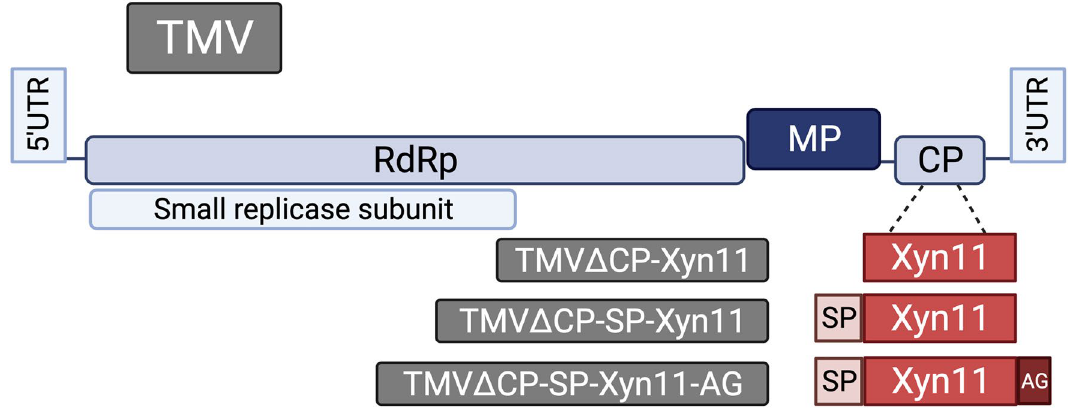
Figure 1. Schematic representation of TMV-derived viral vectors to express different forms of xylanase Xyn11. Boxes represent viral 5 ′ and 3 ′ untranslated regions (5 ′ and 3 ′ UTR), RNA-dependent RNA polymerase (RdRp), movement protein (MP), coat protein (CP), xylanase Xyn11 (Xyn11), (1–3)-β-endoglucanase signal peptide (SP) and arabinogalactan (AG) glycosylation